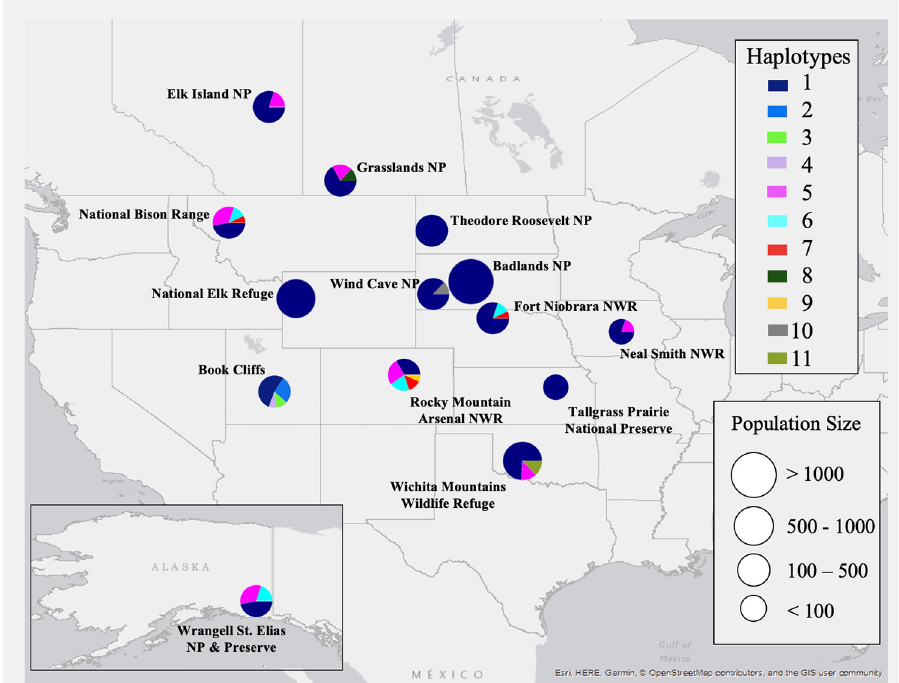
Fig 1. Composition of mtDNA haplotypes (Hap 1 –Hap 11) detected in 14 U.S. Department of Interior and Parks Canada Agency bison herds. Circle sizes are correlated with the size of each herd and the sectors in each chart correspond to percentage of mtDNA haplotypes. The map was created using ArcGIS 1 software by Esri (www.esri. com). Sources: Esri, HERE, Garmin, OpenStreetMap contributors, and the GIS User Community. Contains information from OpenStreetMap and OpenStreetMap Foundation, which is made available under the Open Database